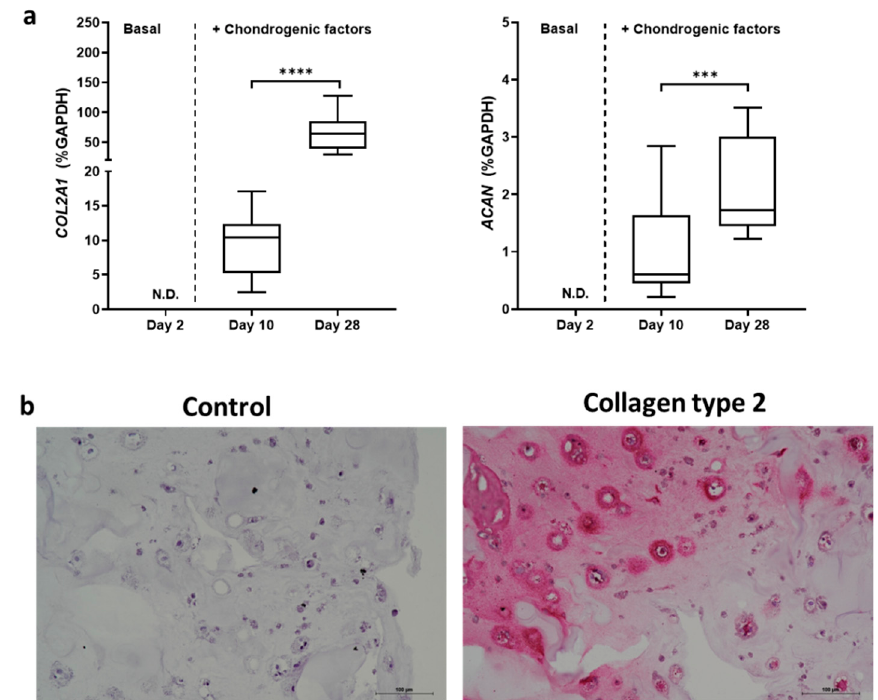
Figure 3. Real-time PCR analysis of COL2A1 and ACAN genes of hASCs embedded in VG-RGD hydrogel at days 2, 10, and 28 ( a ). Data were expressed as % GAPDH (housekeeping gene) and represented as a boxplot with median, minimum, and maximum. Kruskal–Wallis with Dunn’s multiple comparisons test was used for statistical analysis: * indicates differences along time points (day 10 to day 28); *** p < 0.0005, **** p < 0.0001. Representative images of immunohistochemical analysis at day 28: negative control (control) and collagen type 2 ( b ). Positive areas are pink. Bar = 100 µm.